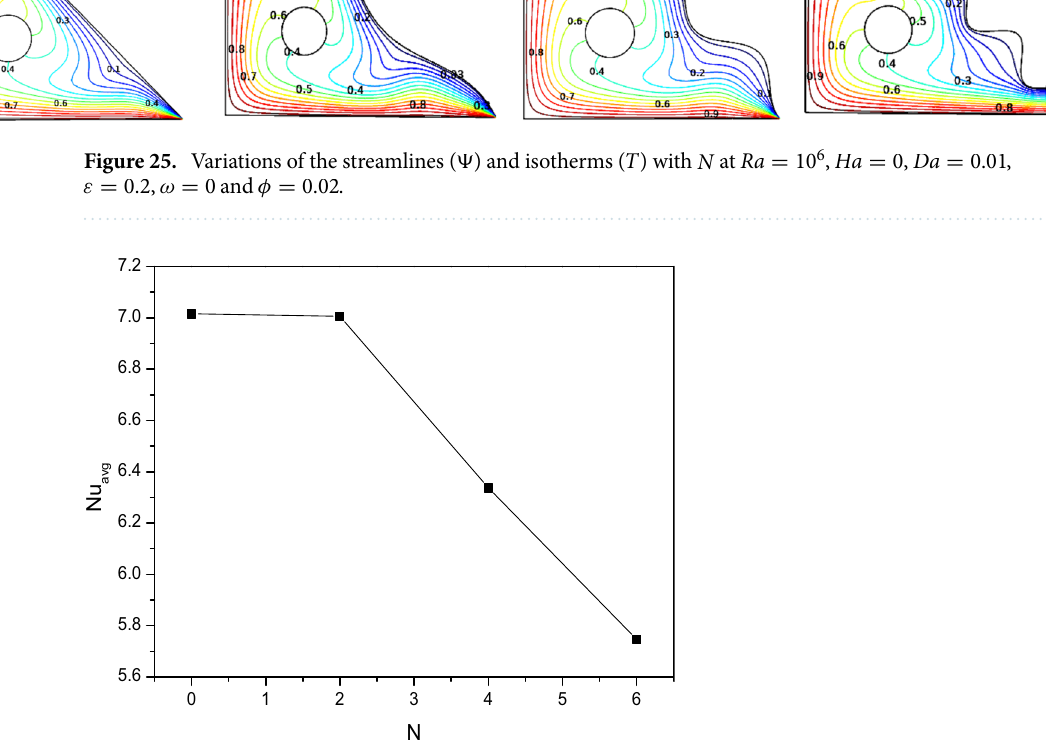
Figure 26. Variations of Nu avg with N when Ra = 10 6 , Da = 0.01 , Ha = 0 , ω = 0 , r = 0.1 and φ = 0.02